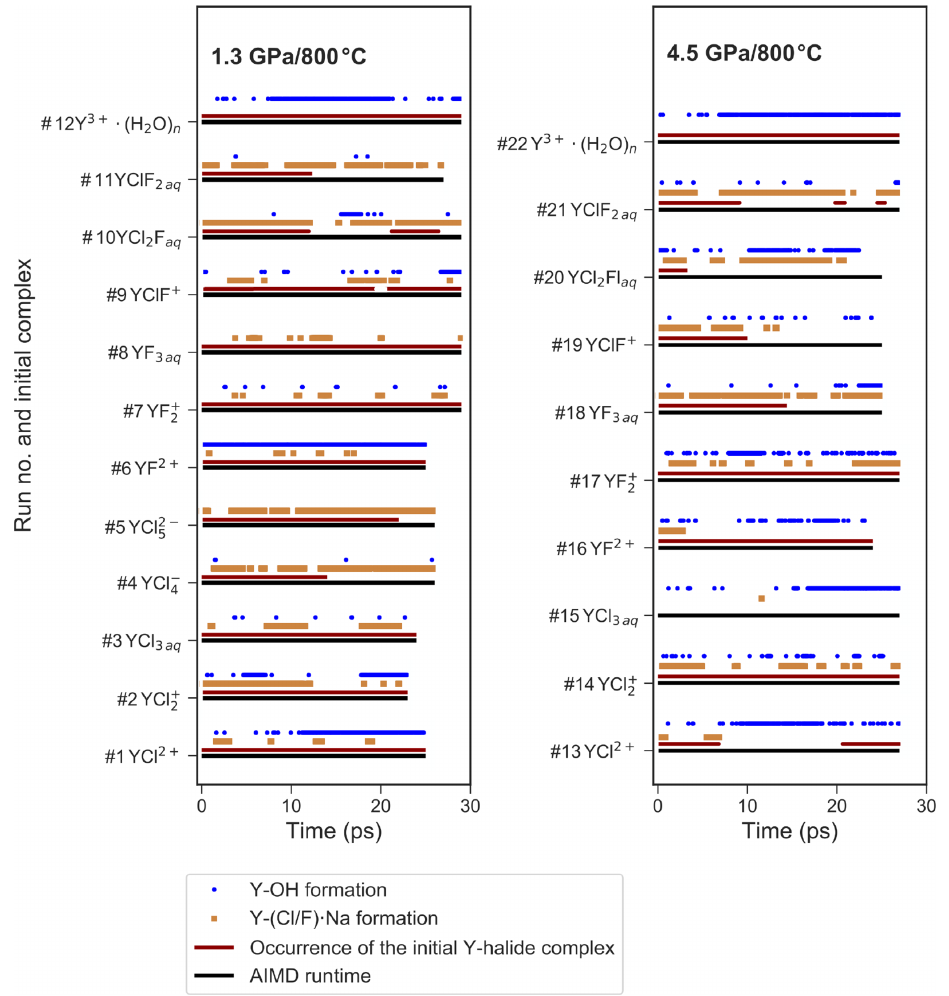
Figure 5. Presence of selected ion pairs or complexes during the different AIMD simulations. This includes the formation of OH − within the first hydration shell of yttrium, the association of sodium with the coordinating halogens and the stability of the initial Y–halide complexes over AIMD